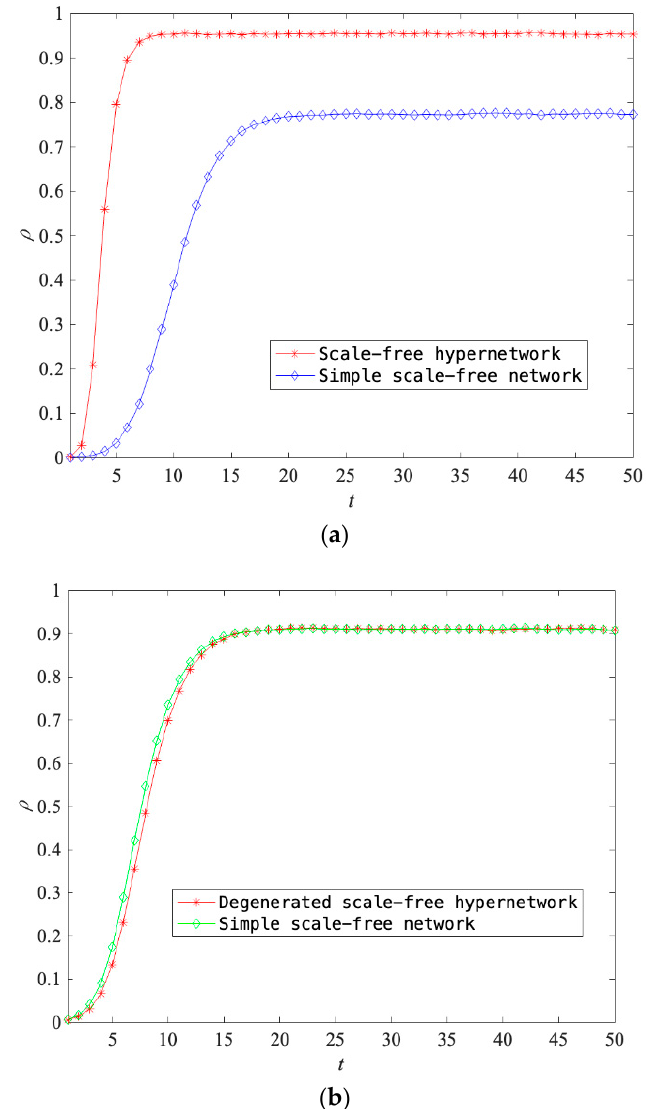
Figure 5. The simulated density of infected nodes ρ vs. time t for different network structures. ( a ) Contrast between scale-free hypernetwork and simple scale-free network; ( b ) Contrast between degenerated scale-free hypernetwork and simple scale-free